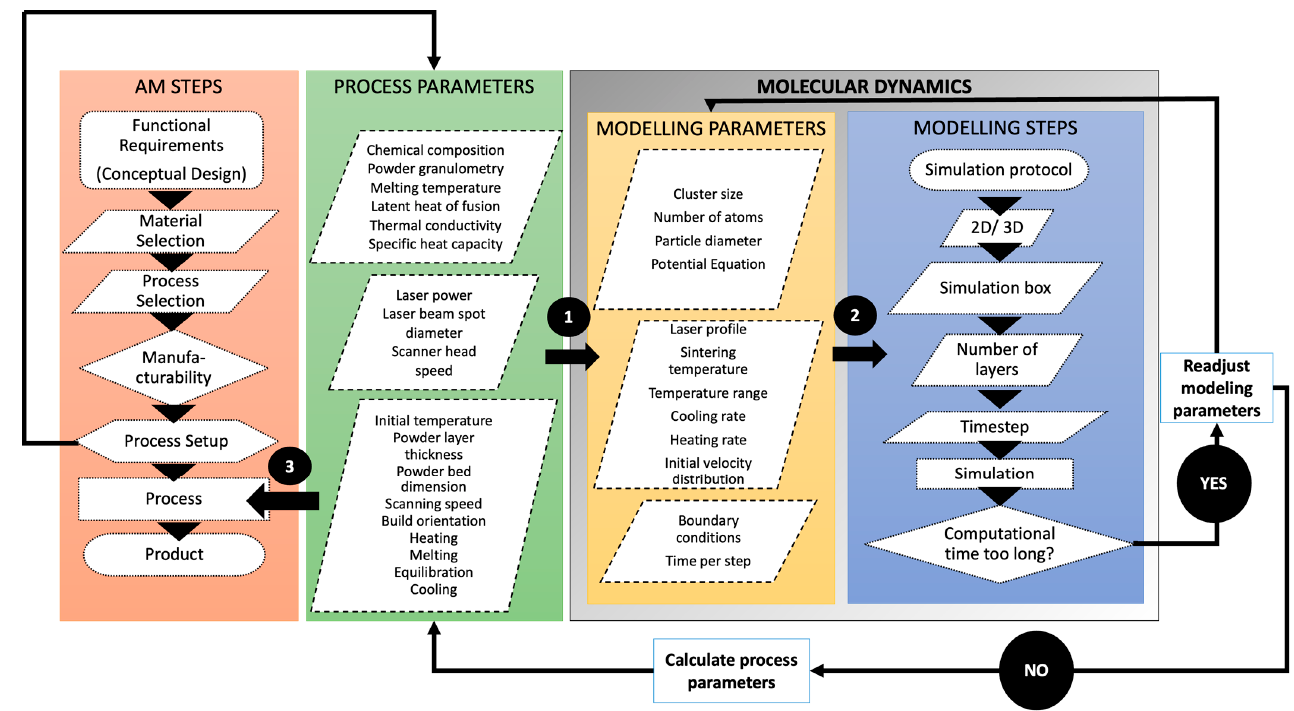
Figure 2. Flowchart of the framework, with process setup defining the process parameters, process parameters defining the modeling parameters (arrow number 1), modeling parameters defining the simulation protocol (arrow number 2), while final process parameters post-simulation defining the process (arrow number 3).